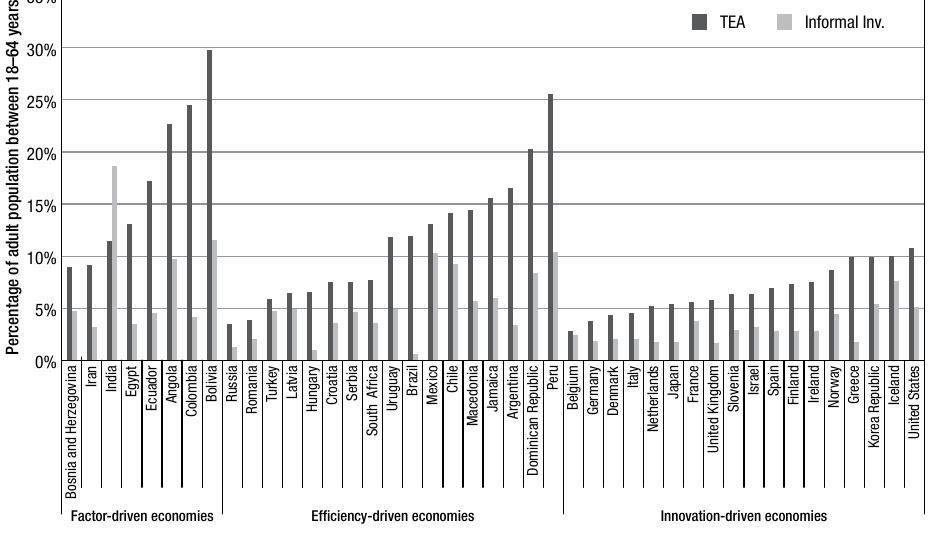
Fig. 1. TEA and rate of active informal investors Source : GEM data